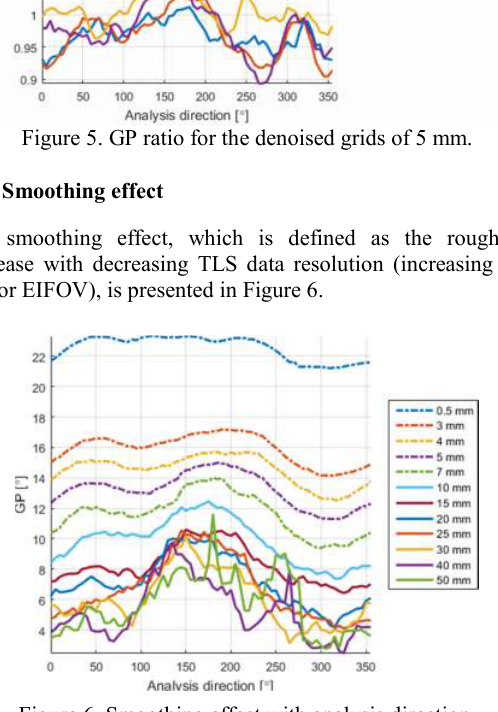
Figure 6. Smoothing effect with analysis